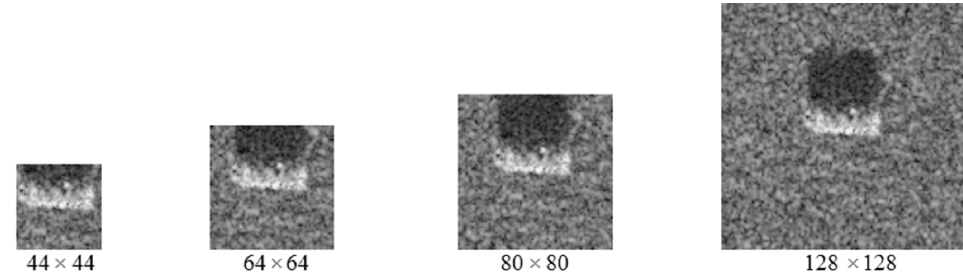
Figure 1. The 128 × 128 pixel patch is one of the BTR70 raw images, and the other three patches are cropped patches from the 128 × 128 pixel patch.